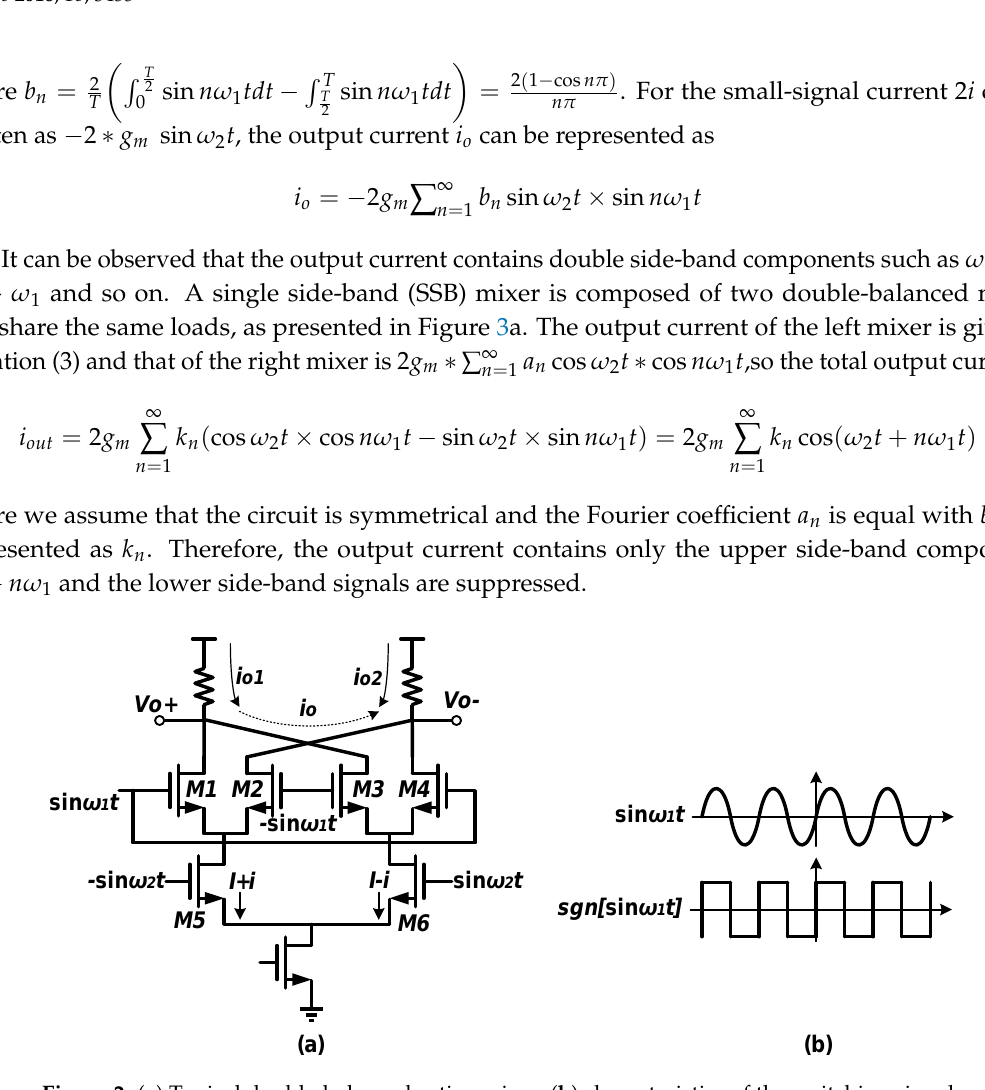
Figure 2. ( a ) Typical double-balanced active mixer; ( b ) characteristics of the switching signal.